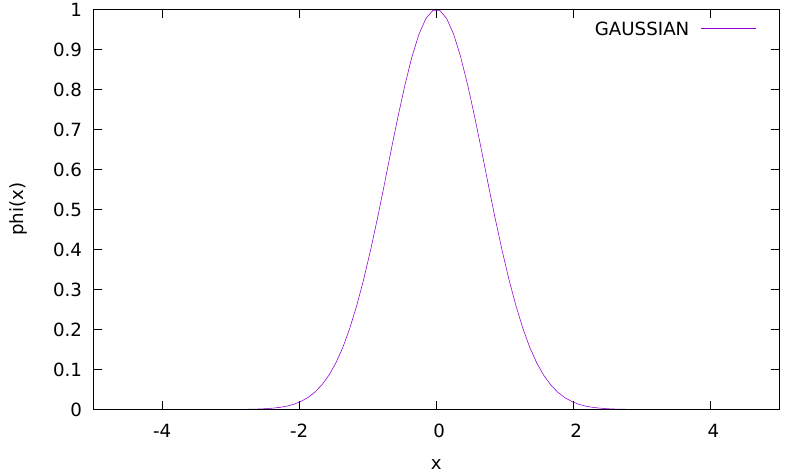
Figure 1. A typical plot for the Gaussian function, for c = 0 and σ =